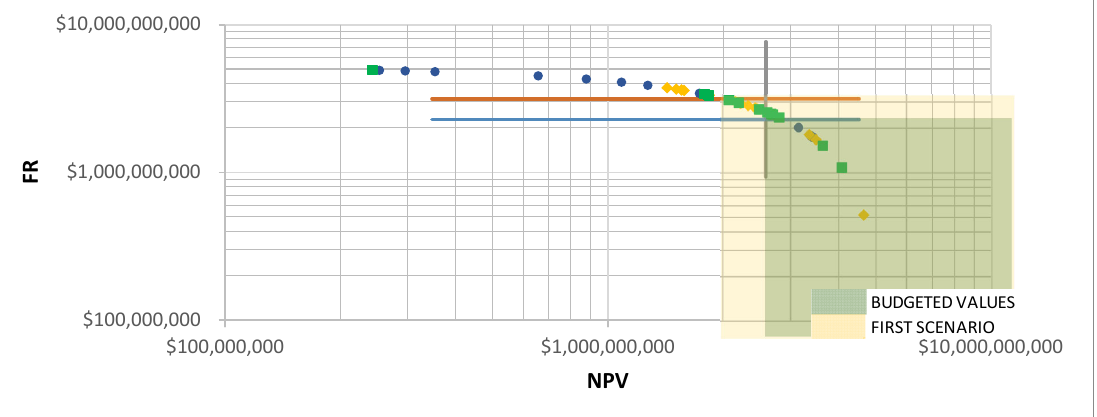
Fig. 17. Pareto solutions front with the best solutions found by FePIA methodology